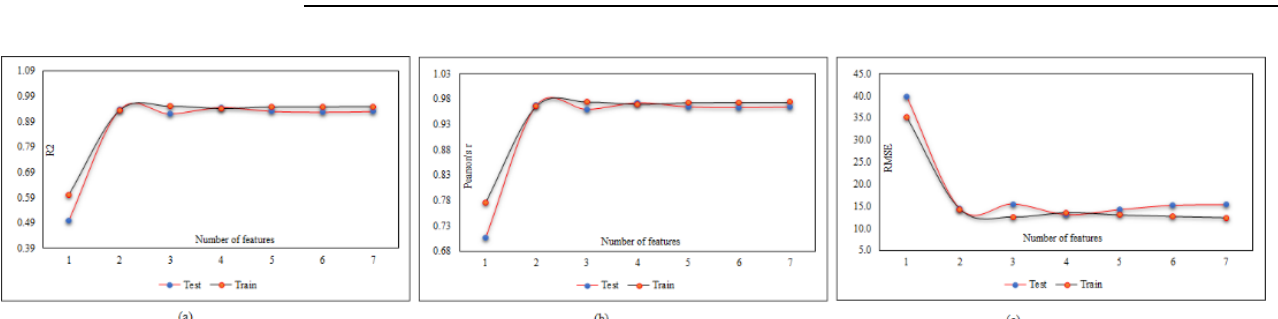
Figure 22. MPF adjustment based on inputs combination: ( a ) effect of inputs combination on R 2 , ( b ) effect of inputs combination on r, and ( c ) effect of inputs combination on RMSE .